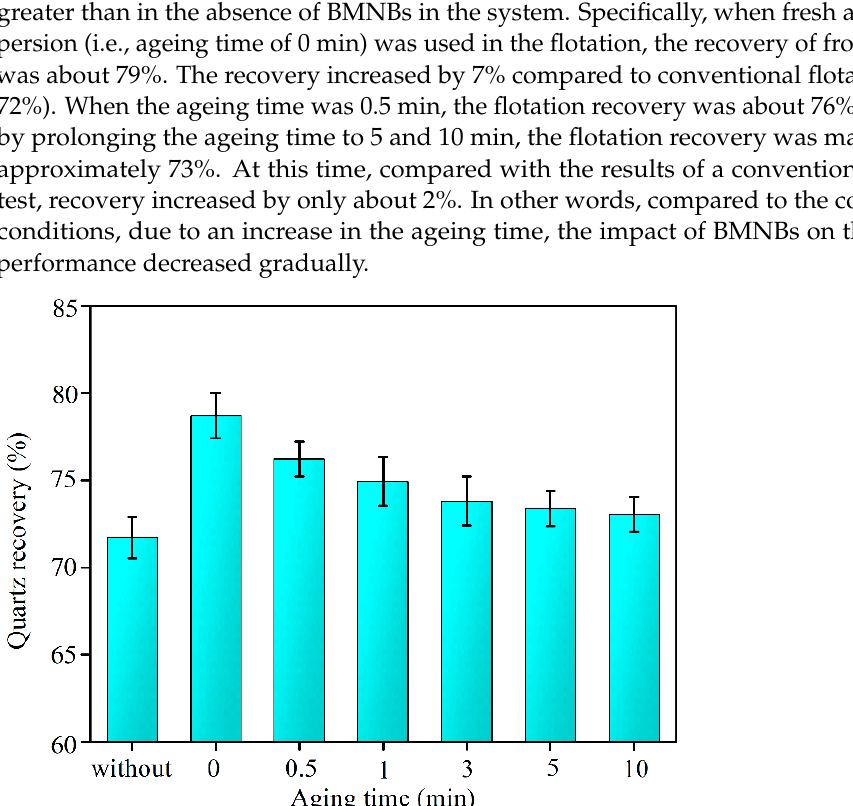
Figure 9. Size distribution and concentration of BNBs as a function of ( a ) preparation time at constant aeration rate of 0.5 L/min and ( b ) aeration rate at a stationary 2 min of preparation time.